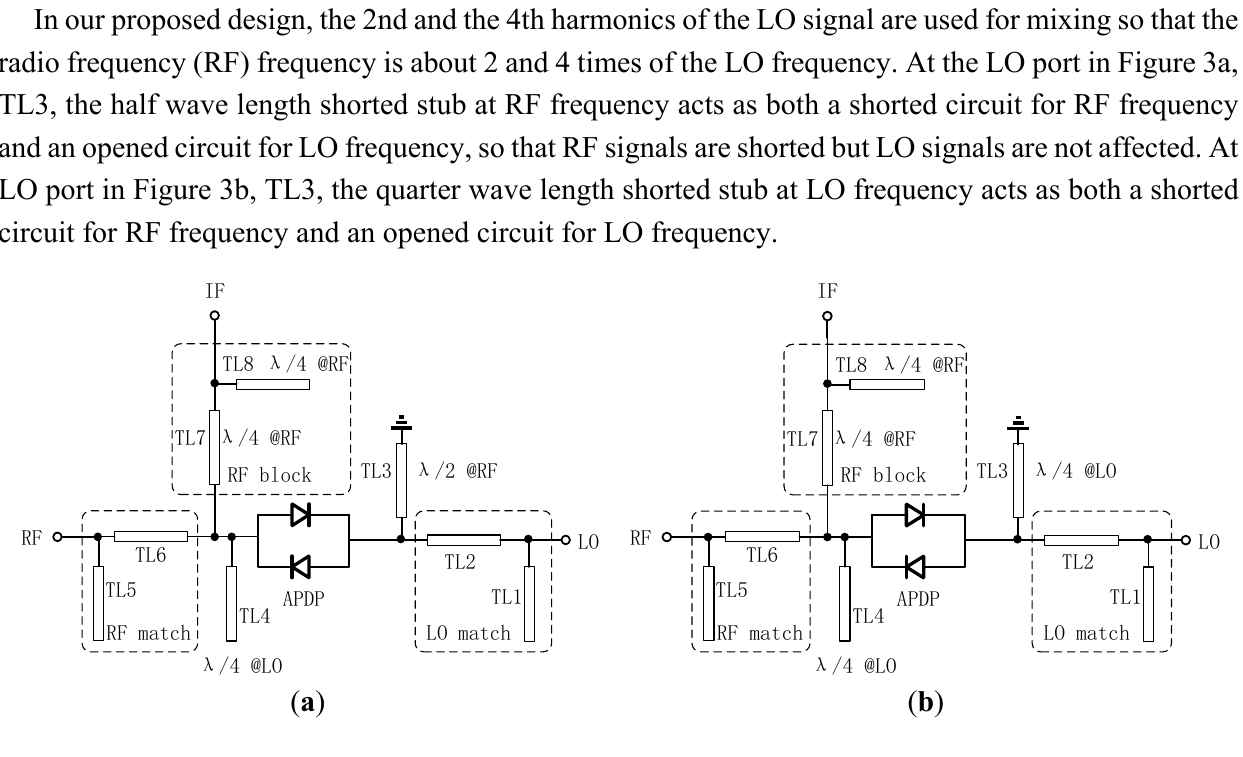
Figure 3. Topology of the 340 GHz sub-harmonic down-mixers: ( a ) 2× sub-harmonic mixer (SHM) and ( b ) 4×